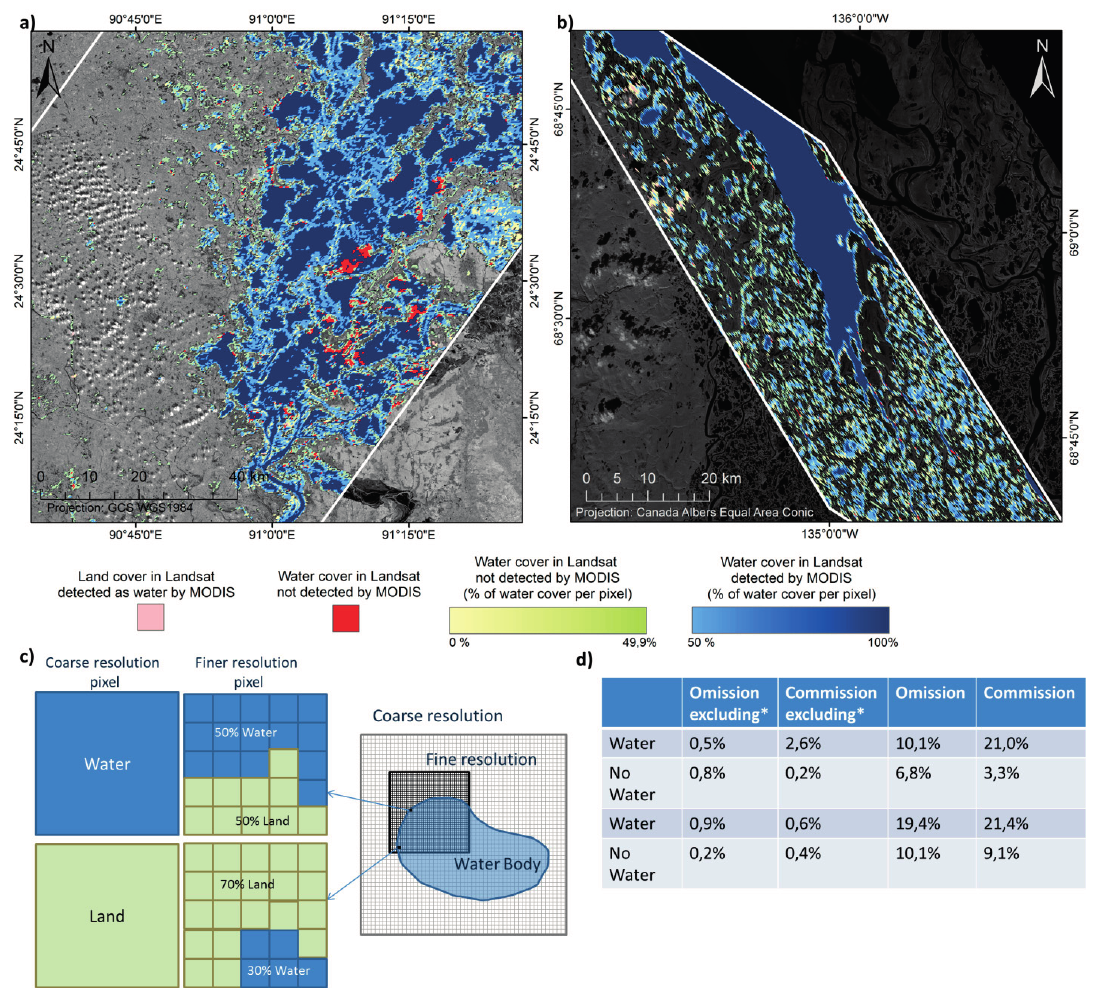
Figure 9. Validating the MODIS derived daily inundation (“water mask”) with water surfaces derived from higher resolution Landsat data of the same day. ( a , b ) representation of water coverage derived from MODIS and Landsat data respectively, ( c ) schmetic sketch of the mixed pixel phenomenon, ( d ) omission and commission